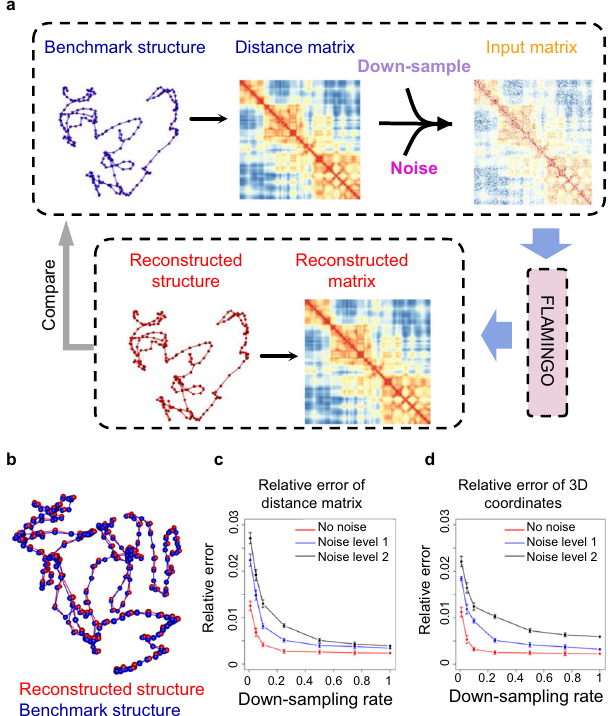
Fig. 2 Performance evaluation based on simulations. a Given a benchmark structure, the distance matrix is down-sampled using different down- sampling rates and mixed with different levels of noise (Noise level 1: low- level; Noise level 2: high-level; see Methods). The incomplete noisy distance matrices are used as inputs for FLAMINGO. The reconstructed 3D structures are compared with the benchmark structure by calculating relative errors and correlations. b One example of the reconstructed structure by FLAMINGO (down-sampling rate = 0.5, noise level 1, see Methods), which aligns with the benchmark structure almost identically (correlation = 0.9999999, relative error = 0.0037). c , d The performance of FLAMINGO (relative errors: the y -axis) under various down-sampling rates and noise levels, with respect to the accuracy of 3D distance matrices ( c ) and 3D coordinates of DNA fragments ( d ). Error bars represent the standard deviations of relative errors examined based on n = 10 independently down-sampled distance matrices under each down-sampling rate. Data are presented as mean values ±SD. Source data are provided as a Source Data fi